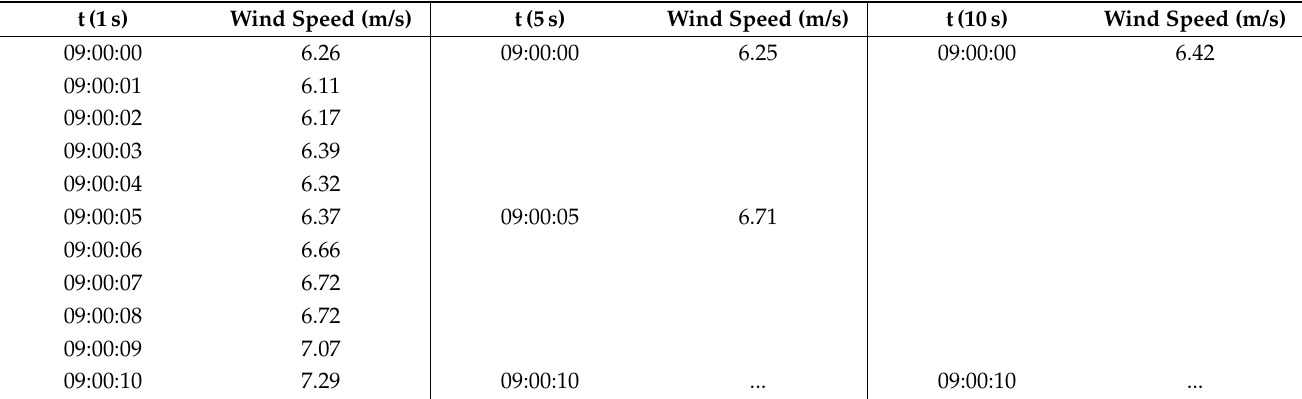
Table 2. Illustration of the temporal aggregation scheme: The original data, i.e., t(1s), is averaged over the lower temporal range and given a new timestamp at the beginning of this interval, see t(5s) and t(10s). t(1s) Wind Speed